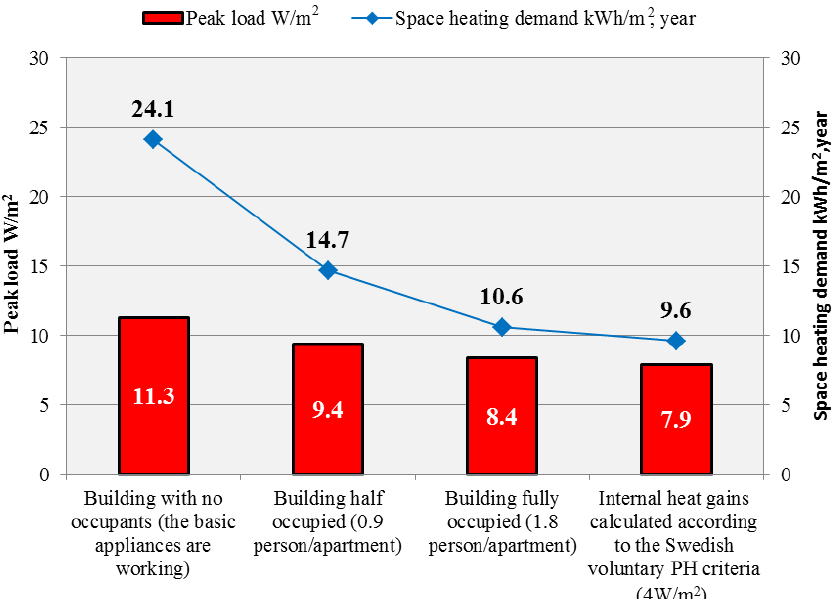
Figure 5. The effect of different levels of internal heat gains on peak load and space heating